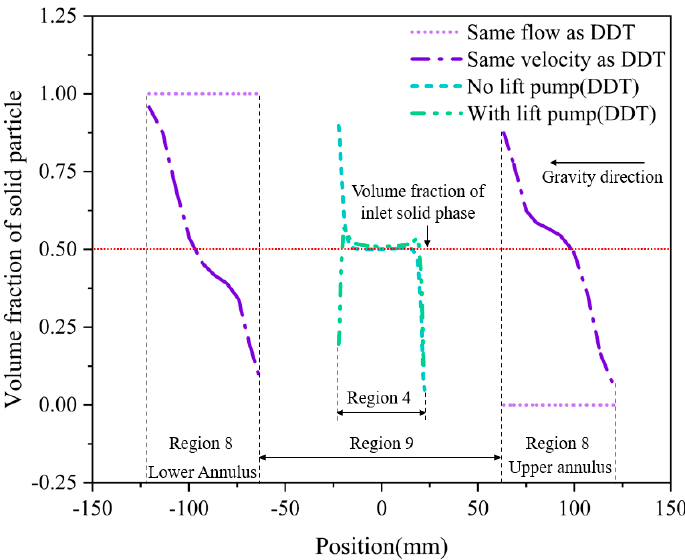
Figure 14. Comparison of migration between the two methods at the same flow rate.